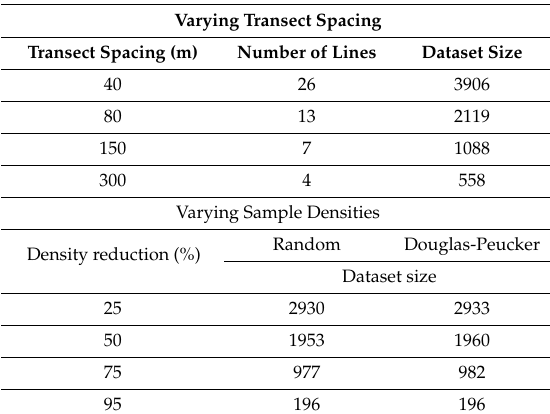
Table 1. Soil electrical conductivity (ECa) input simulation datasets from all sampling designs, showing: (a) average transect spacings, number of remaining transect lines and dataset size from the transect spacing approach; and (b) sample density and dataset size from random sampling and Douglas-Peucker reduction. Varying Transect Spacing Transect Spacing (m) Number of Lines Dataset Size 40 26 3906 80 13 2119 150 7 1088 300 4 558 Varying Sample Densities Density reduction (%) Random Douglas-Peucker Dataset size 25